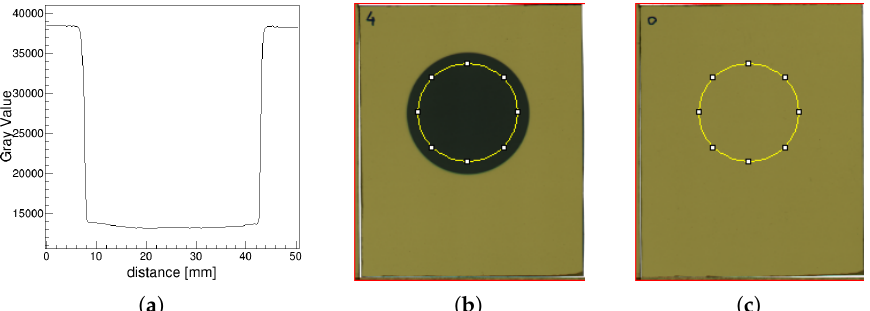
Figure 4. ( a ) colour level profile and ( b ) irradiated area of a piece of EBT3 film irradiated during approximately six minutes. The optical density associated with this piece of film is computed using Equation (1), where I is the mean color value inside the yellow circular region in ( b ) and I 0 is the mean color value inside the same region in ( c ), which is a piece of non-irradiated film from the same sheet. A maximum deviation from the mean value of 4% is observed in the yellow region in ( b ).